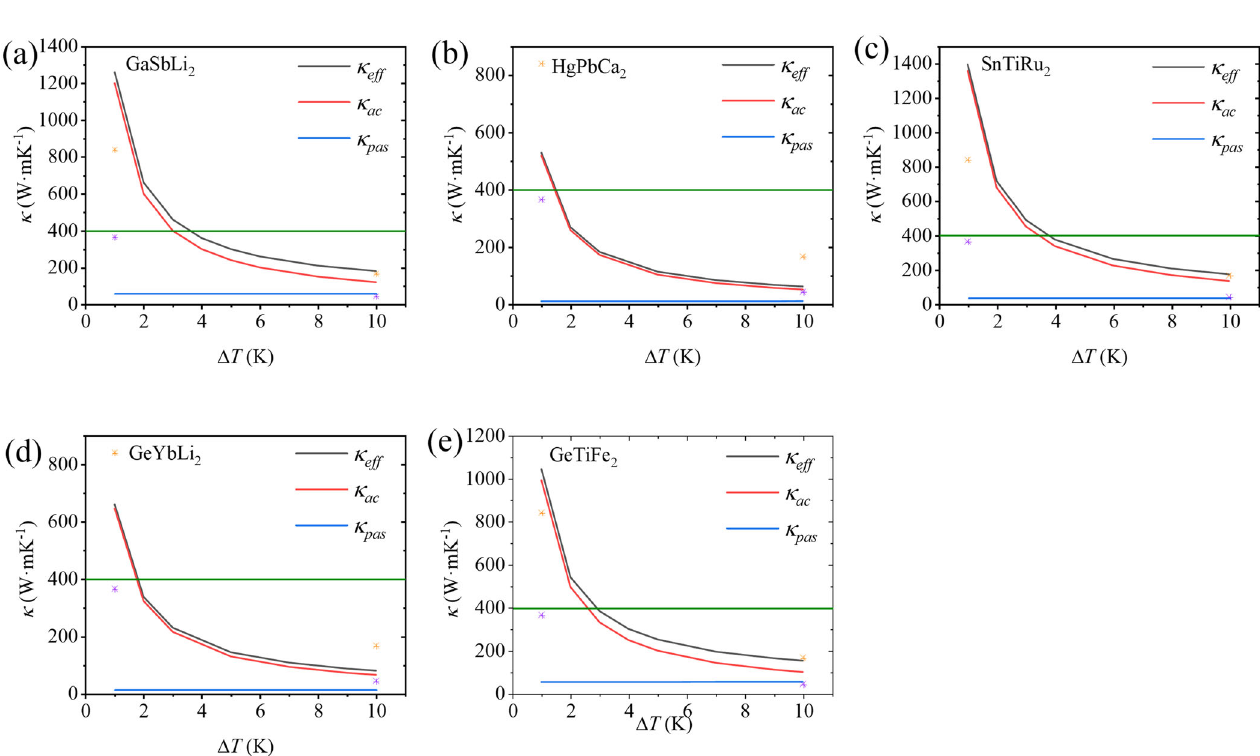
Fig. 3 Effective thermal conductivities with Δ T = 1 K – 10 K. a GaSbLi 2 b HgPbCa 2 c SnTiRu 2 d GeYbLi 2 e GeTiFe 2 . In each plot, the black line represents κ eff , the red line κ ac , the blue line κ pas , and the green line represents the thermal conductivity of Cu at room temperature. The orange and purple asterisks represent the effective thermal conductivity of Co and CePd 3 at Δ T = 1 K 8 ,